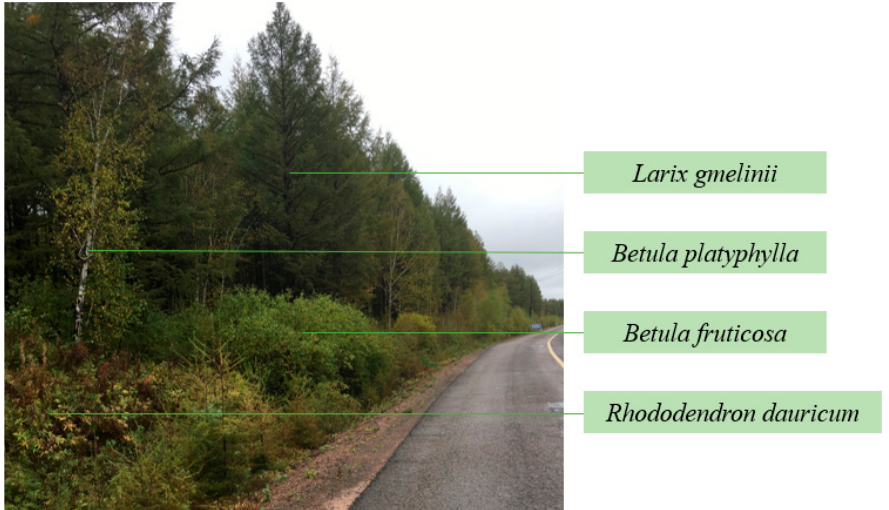
Figure 3. Larch forest cover of K67+300 subgrade section.